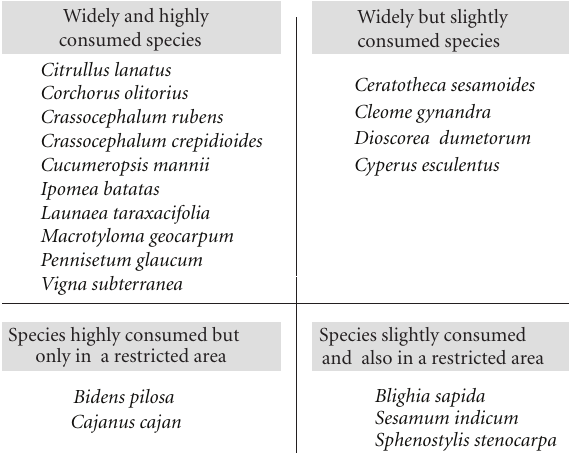
Figure 4: Classification of the Benin priority neglected and underutilized crop species according to their extent and degree of